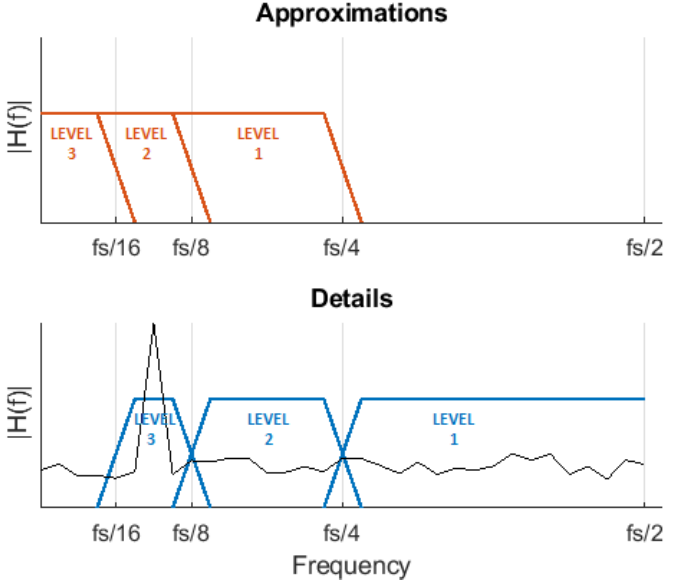
Figure 2. 3-level bandwidth decomposition performed by DWT dyadic filters, superimposed on the spectrum of original current signal (black